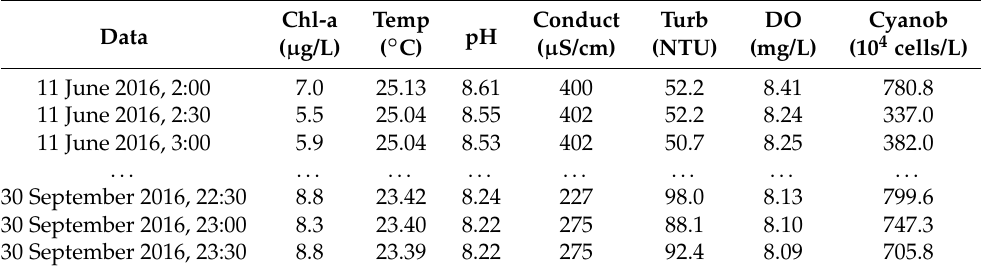
Table 1. Some of the data obtained from S9